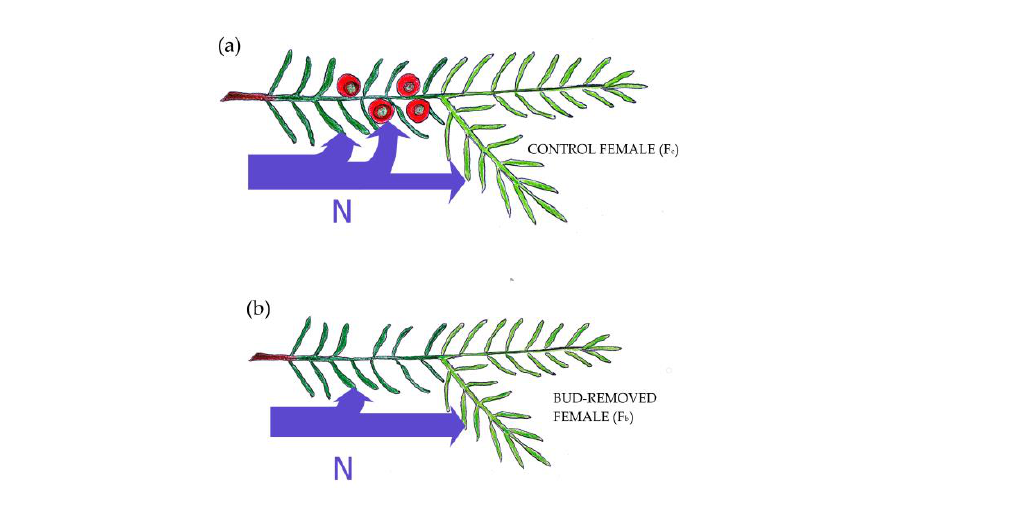
Figure 4. Diagram showing the flow of nitrogen, and possibly other elements, in Taxus baccata female shoots, depending on their reproductive efforts. N is transported to 1-year-old needles (dark green) and current-year needles (light green). ( a ) In the control female N is detained in developing arils, while ( b ) in the bud-removed female more N is available for developing, current-year needles. In addition, sex-related differences in N concentration, as well as C:N ratio, appeared only in relation of F c shoots to M shoots, and they were absent between F b and M shoots.